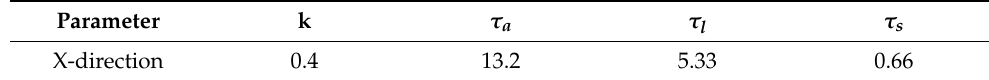
Table 2. Coefficient of otolith model.